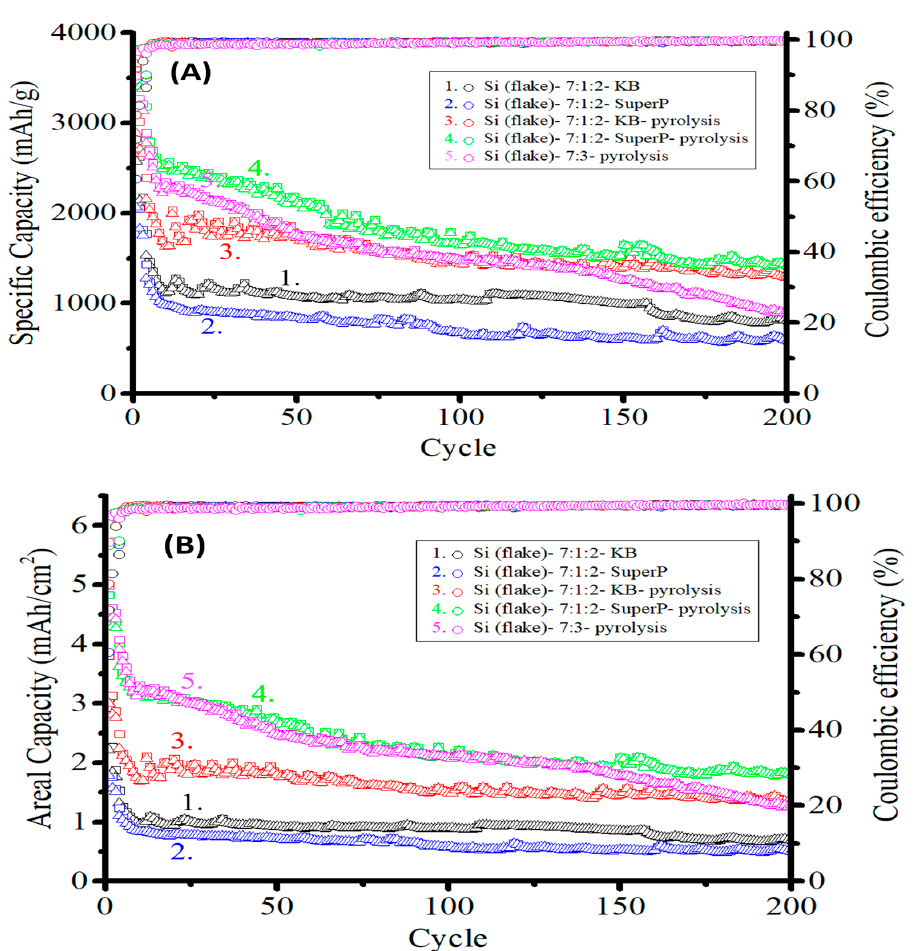
Figure 10. ( A ) Specific capacity and ( B ) areal capacity cycling performance of anodes made of: (1)